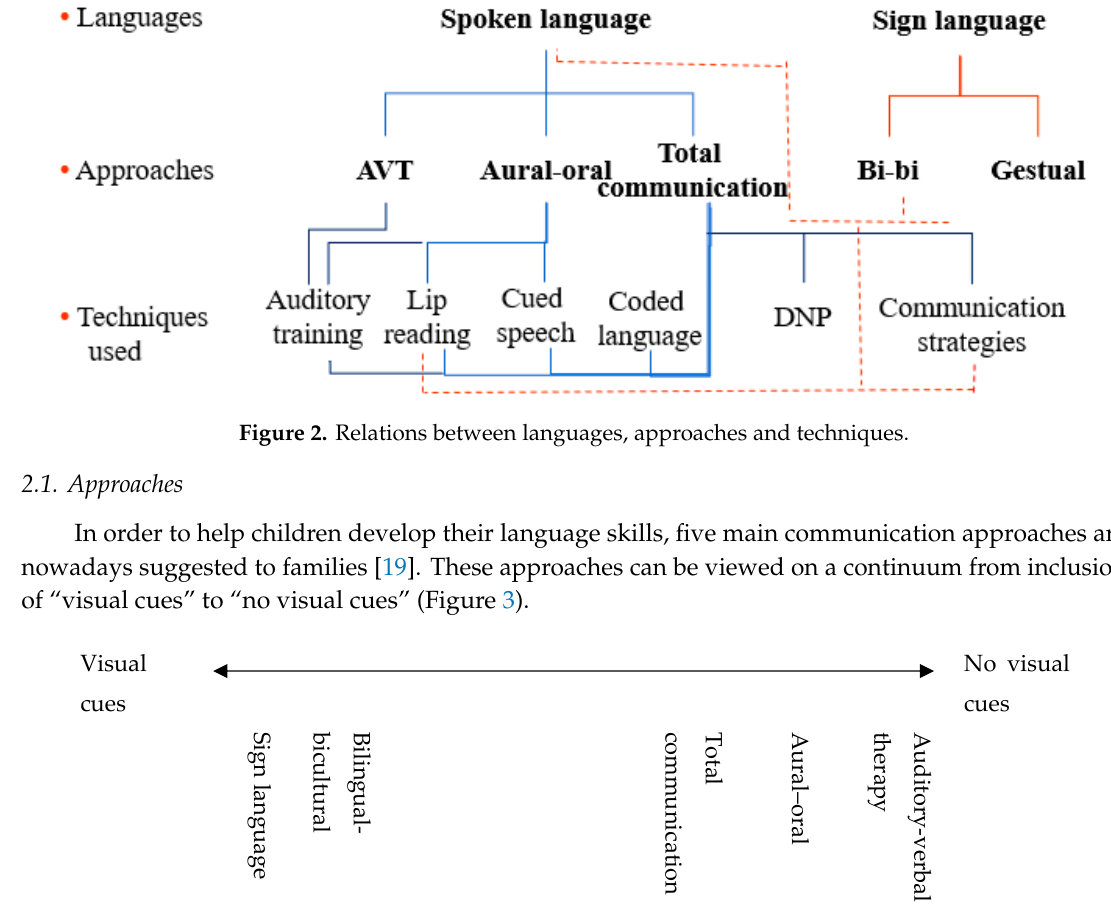
Figure 3. Approach Figure 3. Approach continuum. Figure 3. Approach continuum.